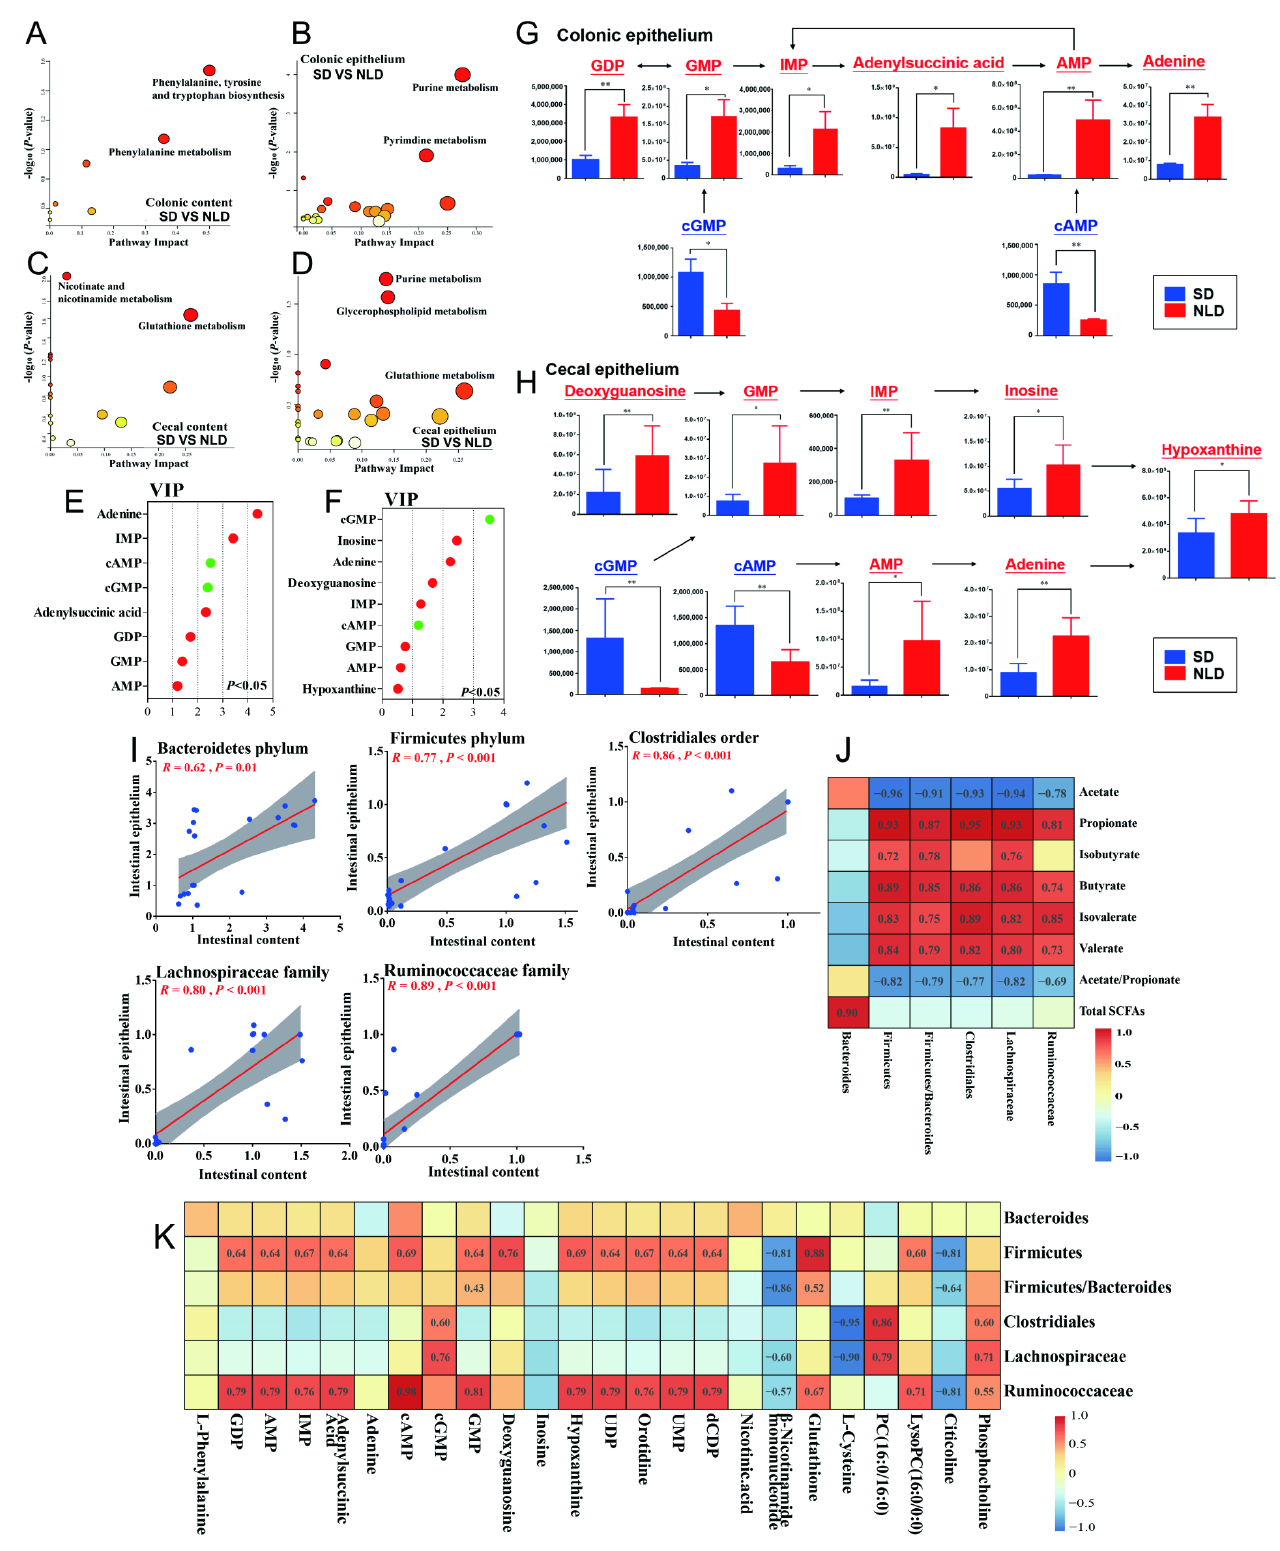
Figure 7. Characterization and functional analysis of key metabolic pathways and correlations be- tween gut microbes, SCFAs proportions, and metabolites. NLD, the antibiotic-treated mice managed under normal light–dark cycle; SD, the antibiotic-treated mice managed under short-day cycle. Pathways were enriched via enrichment and topology analysis of significantly different metabolites in colonic contents ( A ), colonic epithelium ( B ), cecal contents ( C ), and cecal epithelium ( D ) in ABX mice under NLD and SD. Large sizes and red colors represent high pathway impact and major